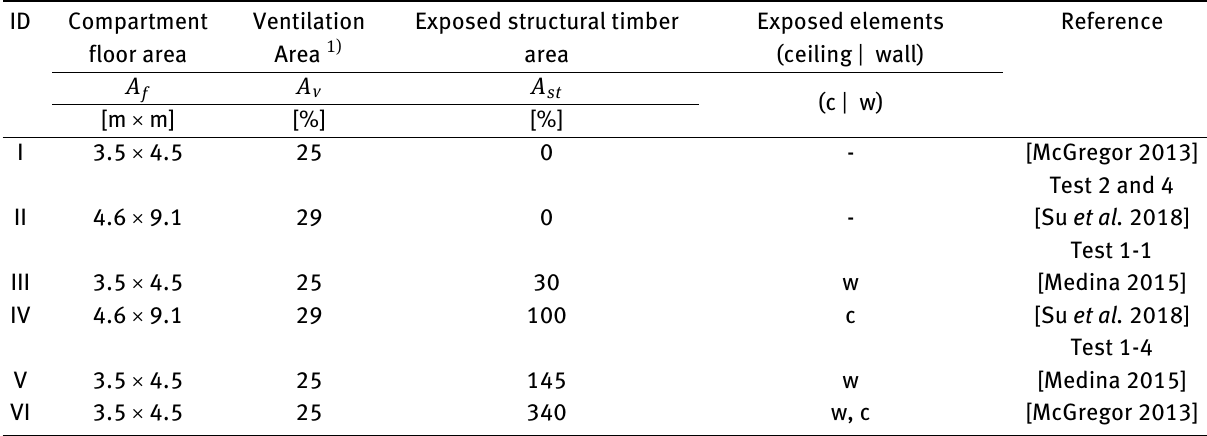
Table 2: Overview of the compartment experiments included in the